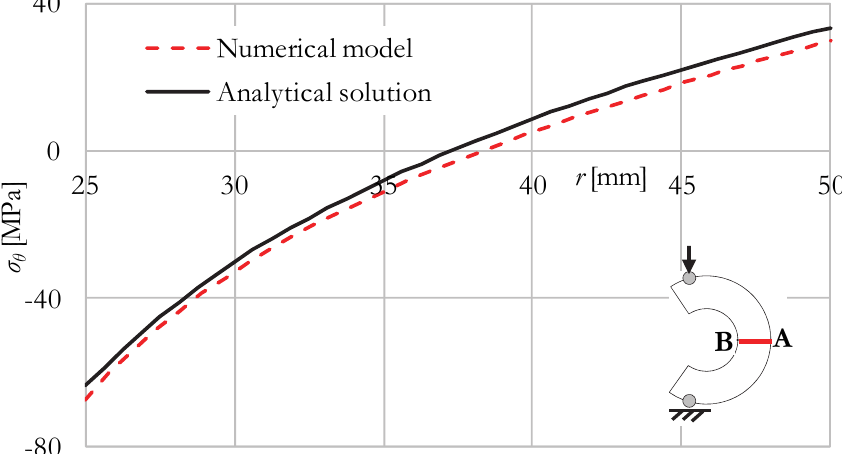
Figure 16: The distribution of the transverse normal stress along the critical locus AB, according to the analytical solution and the data provided by the numerical model (for the reference